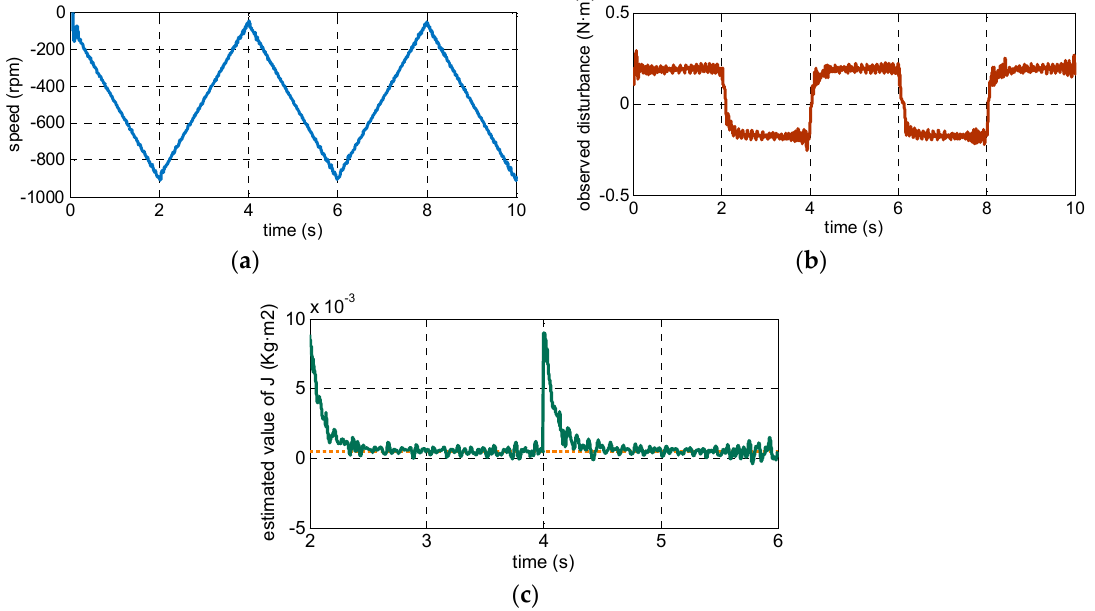
Figure 15. Experimental results under an acceleration of ±420 rpm/s for J 0 = 10 J : ( a ) Measured speed; ( b ) observed disturbance value for parameter mismatch error Δ J ; ( c ) estimated value of parameter J .